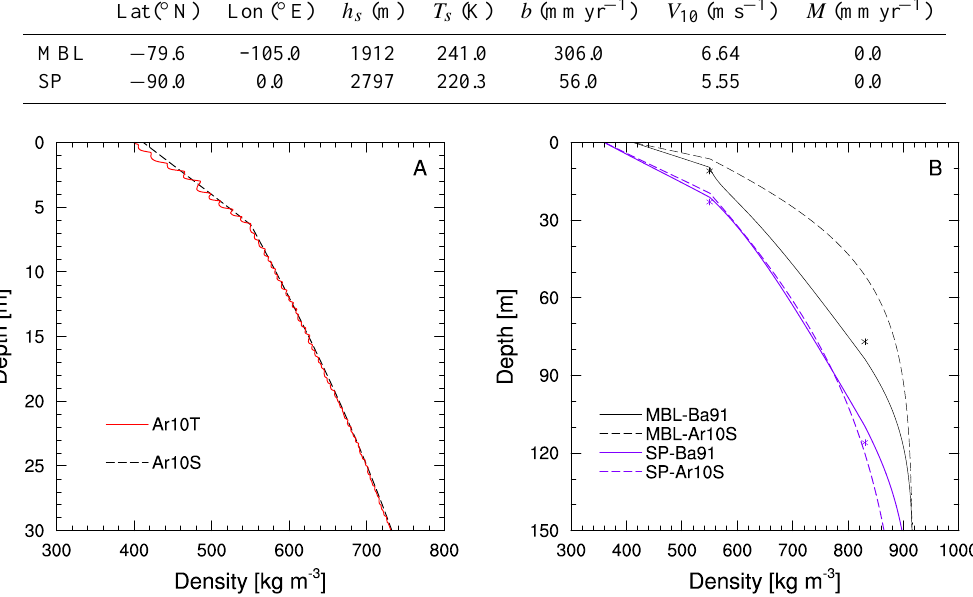
Table 1: RACMO2/ANT climate characteristics of a point in Marie Byrd Land (MBL) and South Pole (SP): latitude, longitude,